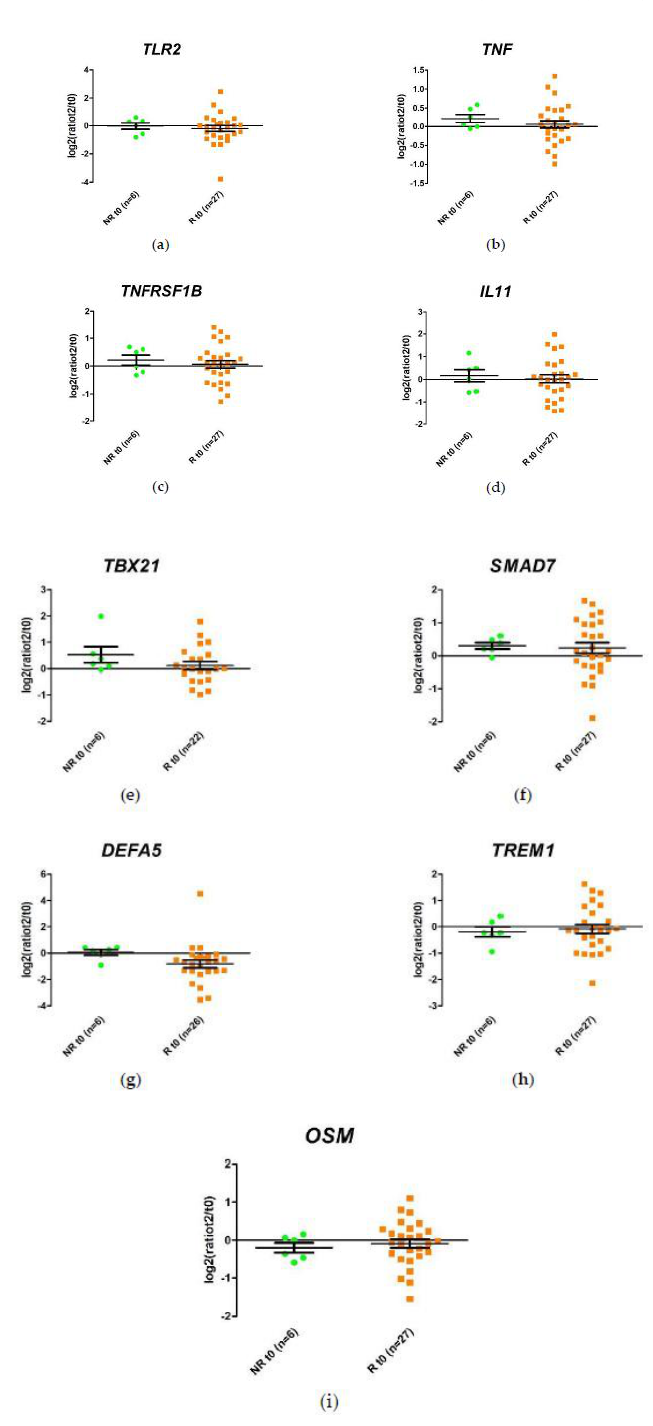
Figure 4. Schematic representation of the ratio between relative expression levels at week 2 (t2) and week 0 (t0) (t2 / t0) of the ( a ) TLR2 , ( b ) TNF , ( c ) TNFRSF1B , ( d ) IL11 , ( e ) TBX21 , ( f ) SMAD7 , ( g ) DEFA5 , ( h ) TREM1, and ( i ) OSM genes in responders (R) and non-responders (NR). Expression values were normalized to HPRT1 and GAPDH genes. Values are expressed as mean (horizontal line), standard error of the mean (SEM). n , sample size. * p value < 0.05 vs. control (unpaired t